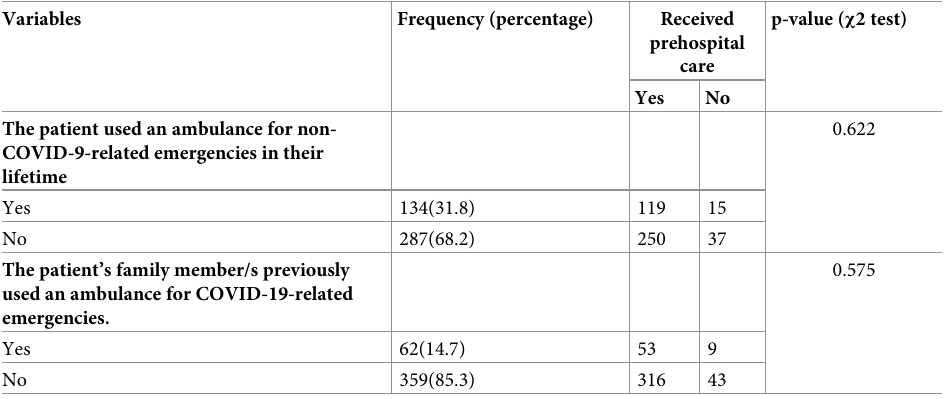
Table 5. Description of health behaviors of the patients and their families by prehospital care utilization among severe and critical COVID-19 patients treated in centers in Addis Ababa, Ethiopia, from May to July 2021. Variables Frequency